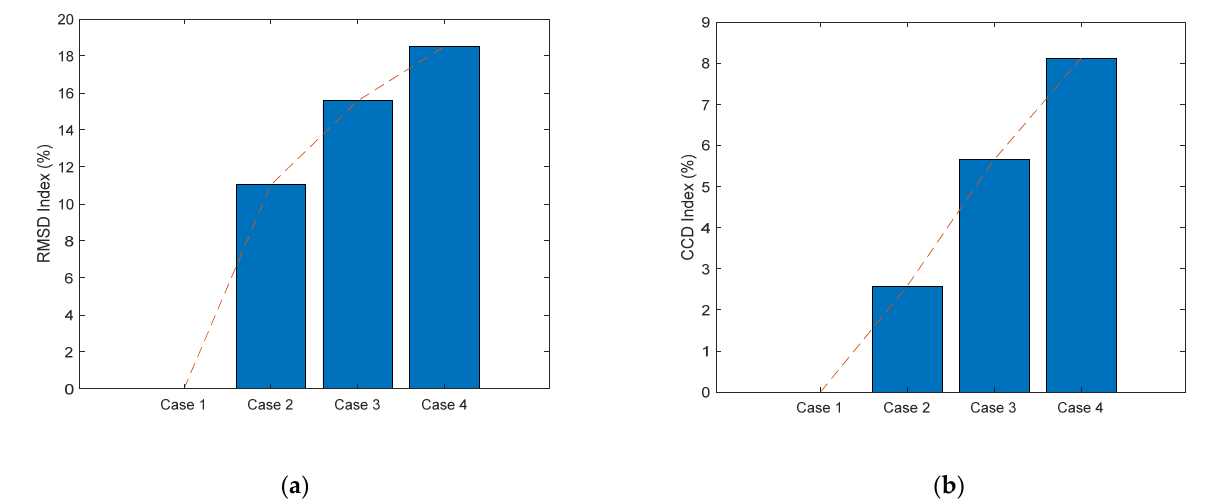
Figure 13. The damage indices for the frequency range of 70–80 kHz. ( a ) RMSD index; ( b ) CCD index.